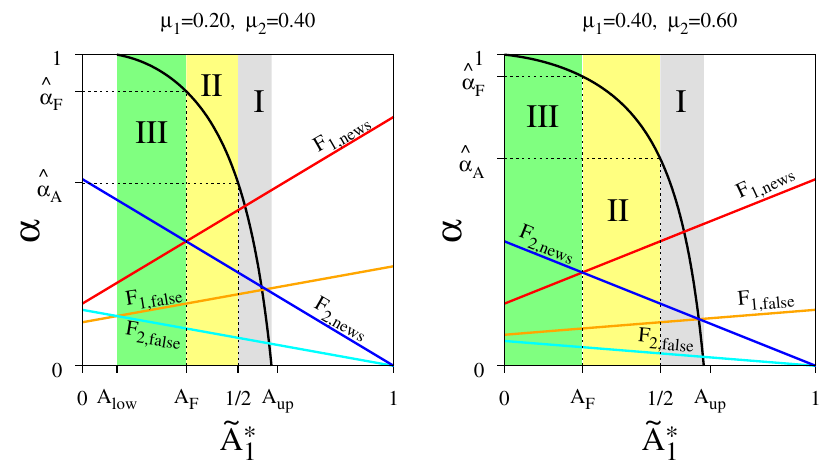
Fig.3 We represent Regions I, II, and III in equilibrium. The left panel considers μ 1 = 0 . 2 and μ 2 = 0 . 4; the right panel considers μ 1 = 0 . 4 and μ 2 = 0 . 6. In each panel, the red line corresponds to the fraction of news published by the low-standard outlet and the blue line to the fraction of news published by the high- standard outlet. The orange and cyan lines correspond to the fraction of false stories published by the low and the high-standard outlet, respectively. The black curve gives the value of parameter α that is required to reach a particular equilibrium audience (cid:2) A ∗ 1 . The vertical lines at A low , A F , 1 / 2 and A up determine the equilibrium size of Regions I, II, and III. The left boundary A low corresponds to the case with no